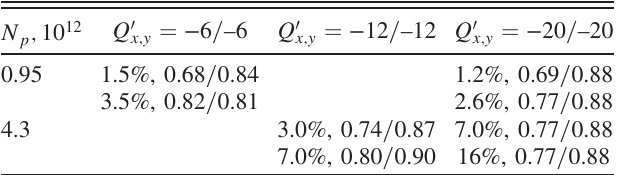
TABLE II. Optimal working points for various injected inten- sities and injection chromaticities: the first line in each box is the minimal intensity loss 1 ms after injection (raw B:CHG0 data, uncorrected for the B:CHG0 systematic errors and the notcher gap cleaning) and the optimal horizontal and vertical tunes Q =Q x y ; the second line is the same for the entire Booster cycle (at extraction).